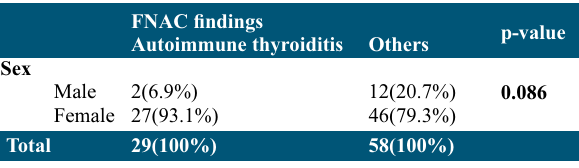
Table 3: Comparison of sex of patients with FNAC ndings of thyroid lesions